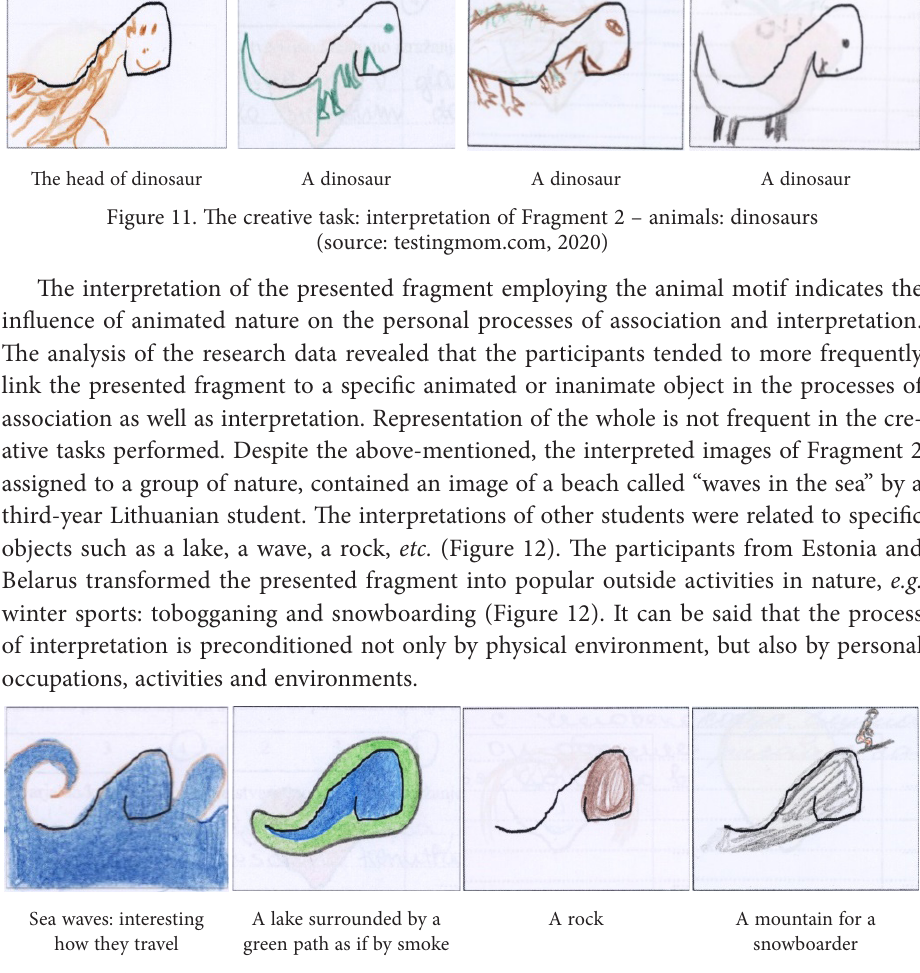
Figure 12. The creative task: interpretation of Fragment 2 – nature (source: testingmom.com, 2020) Fragment 2 in the creative task was associated with tools by 12.2% of the research par- ticipants (Figure 13), and as many as one fifth of them (20.0%) were from Estonia. In the process of interpretation only two students linked the fragment with tools; none of them were from Estonia (Tables 3,